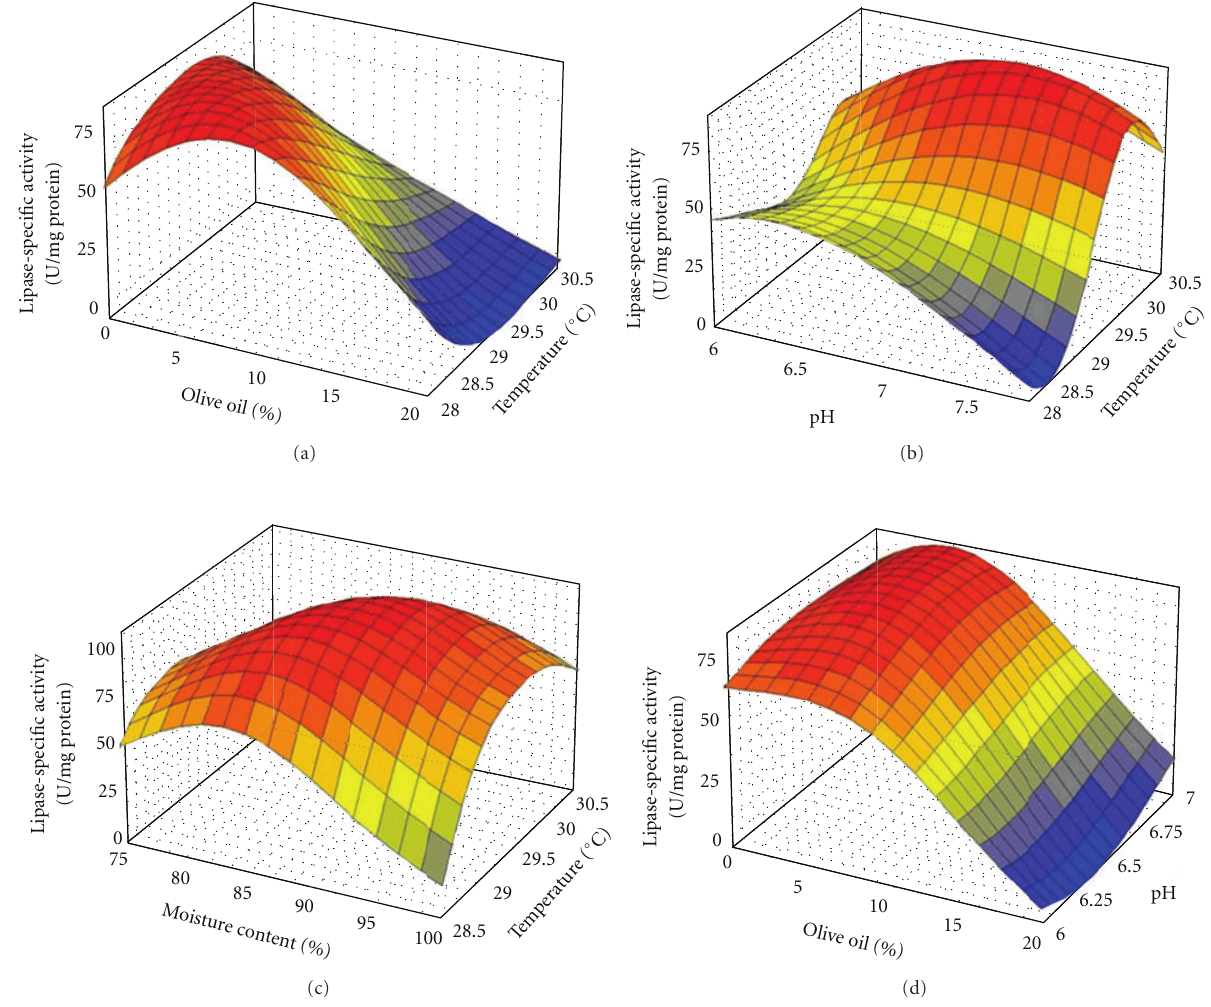
Figure 2: Three dimensional plots for the interaction e ff ect of: (a) olive oil and temperature; (b) pH and temperature; (c) moisture content and temperature and (d) olive oil and pH, on Acinetobacter sp. lipase production in SSF. The colors from blue to gray, green, yellow, orange, and red, respectively, show increasing the lipase-specific